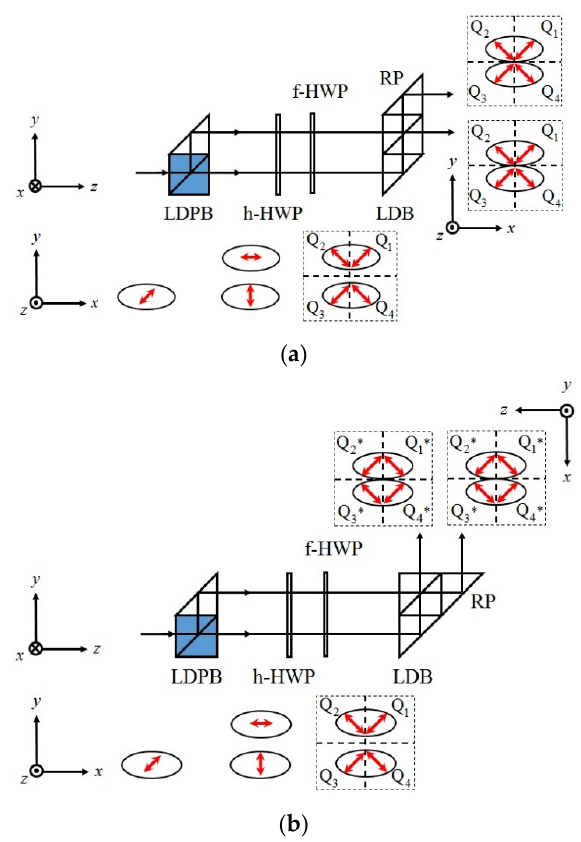
Figure 6. A reflection prism (RP) is applied to transform one mode into another: ( a ) two output radially polarized beams in the + x ‐ direction, and ( b ) two output azimuthally polarized beams + y ‐ direction.